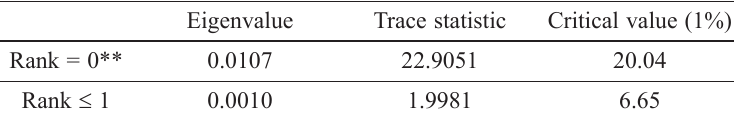
Table 3. Co-integration rank